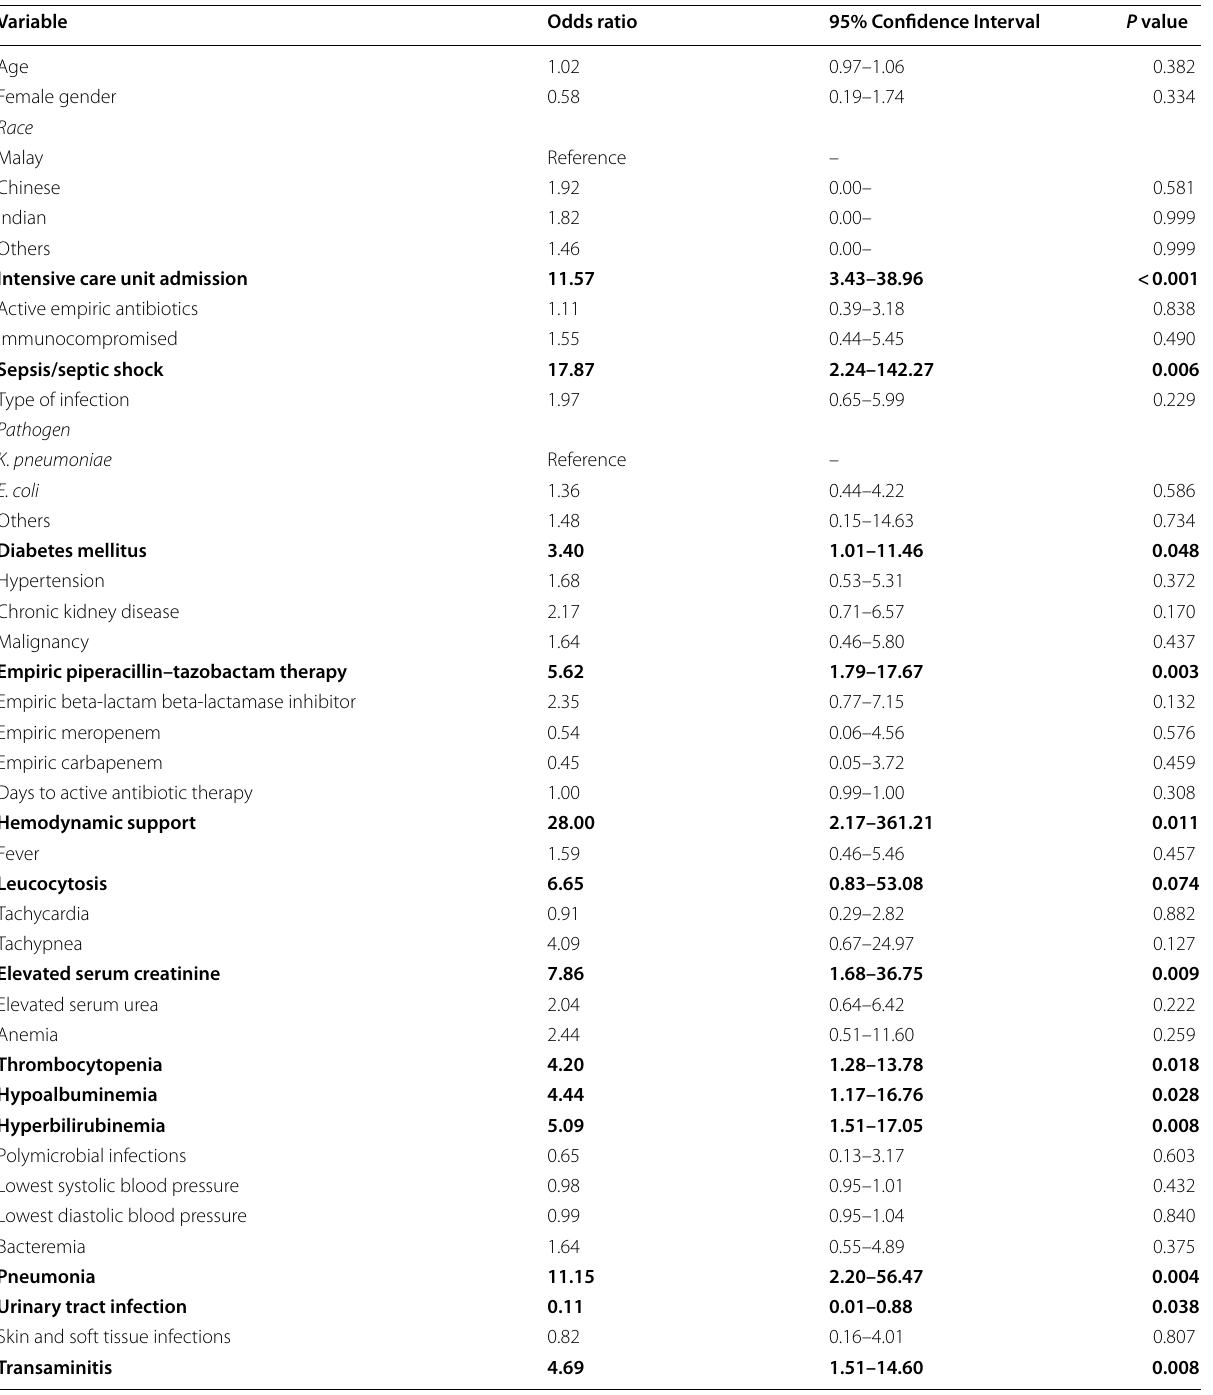
Table 5 Univariate logistic regression analysis for factors associated with in-hospital